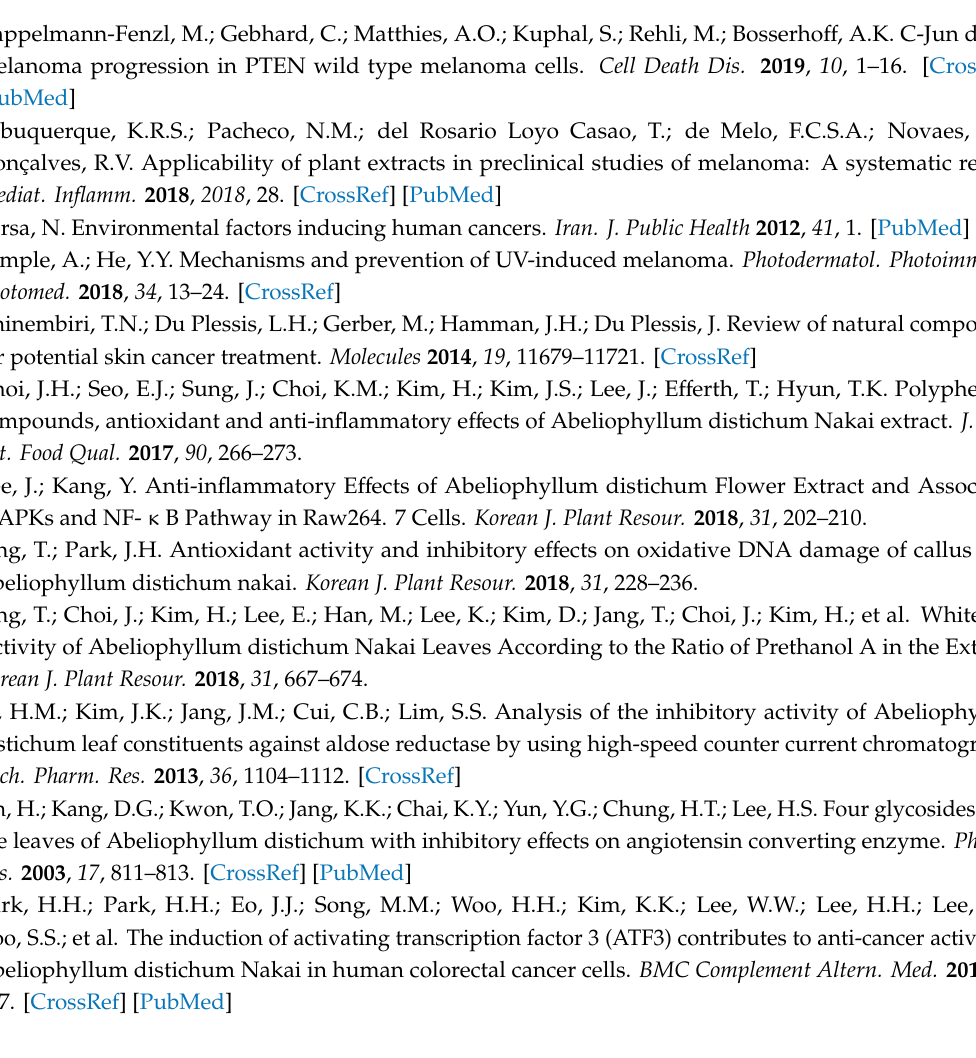
Table S1. Abeliophyllum distichum leaves extract-induced DEGs, Table S2. Primer sequences for real-time PCR analysis, Figure S1. Gene ontology classification of Abeliophyllum distichum leaves extract-induced DEGs. Figure S2. KEGG pathway enrichment analysis using Abeliophyllum distichum leaves extract DEGs (A). Venn diagram analysis of DEGs involved in PI3K / Akt signaling pathway and Rap1 signaling pathway (B). Figure S3. The expression (A) and protein levels (B) of Akt3 in AL-treated SK-MEL-2